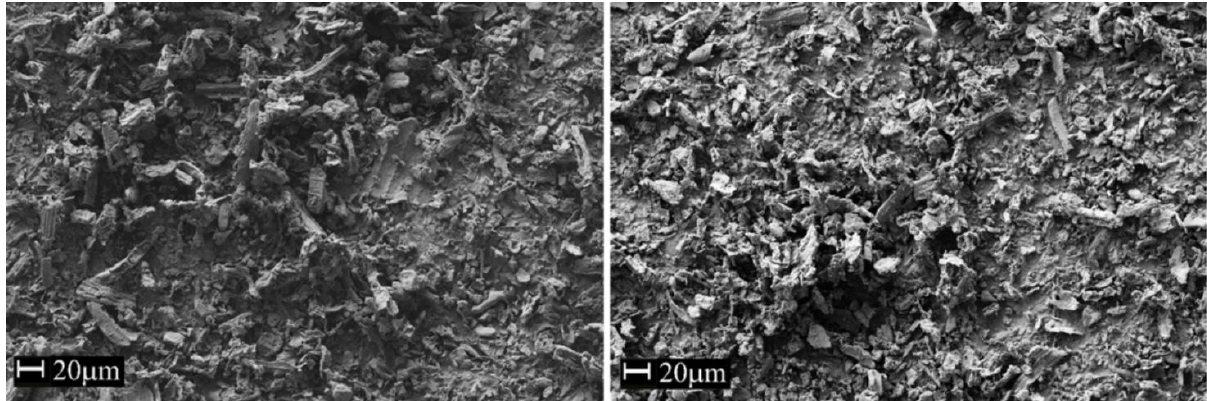
Figure 1. Enlarged particle morphology of the samples: H2 (left) and H6 (right). Table 1. Composition of Sphagnum moss grades, mean and range ( n =